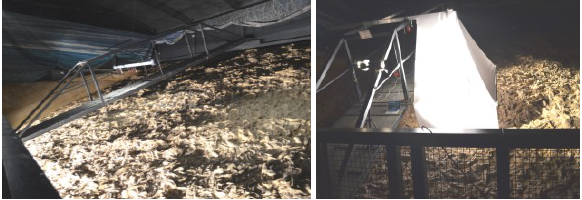
Figure 1. The data collection setups; (a) TLS scanning from mobile bridge; (b) Camera under a special lightning tent. A Canon 60D camera with a Canon EF 20 mm f2.8 lens was used to capture images (each 5184 x 3456 pixels). In average, the ground sample distance was 0.6 mm, and the footprint of the image was about 3.1 m x 2.1 m on the reef side. Images were taken with 80% overlap over the longer image